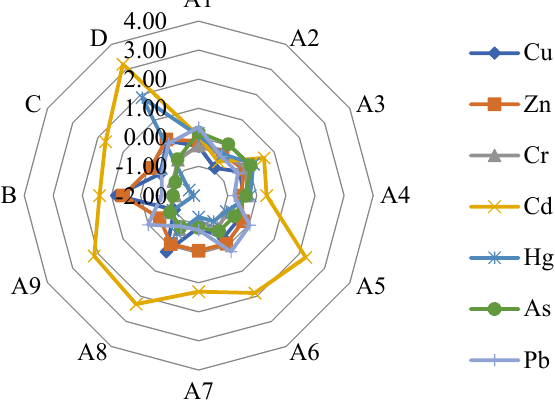
Figure 3. Igeo values in various sample plots.